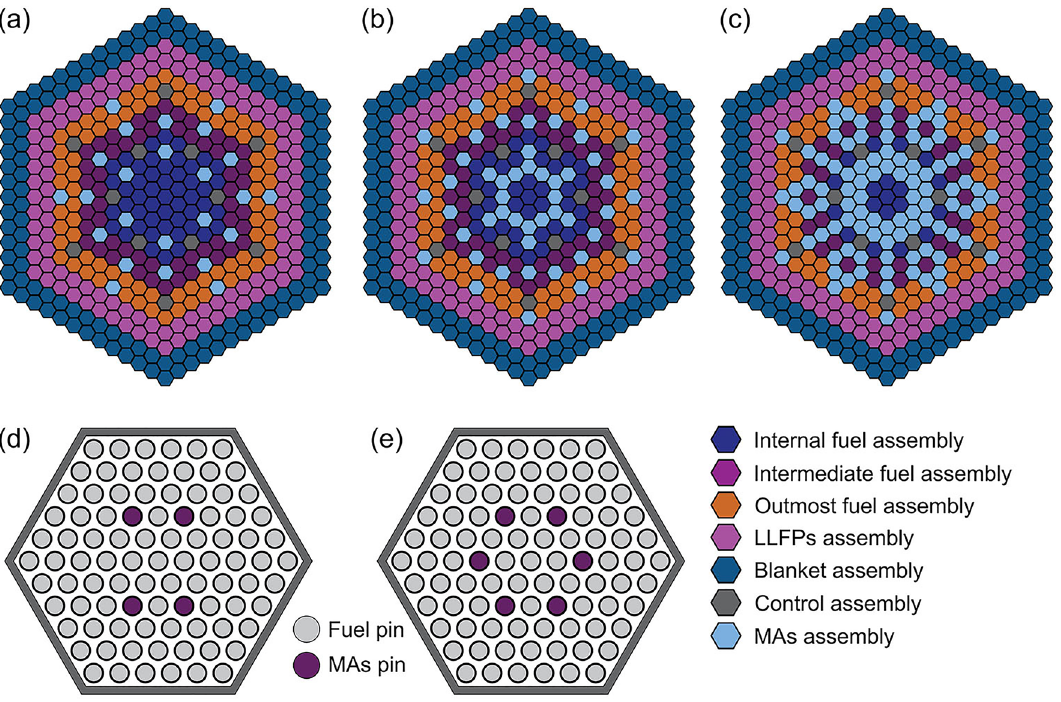
Figure 2. The distribution of MAs assembly in LFR with different loading amounts. In pads ( a ) and ( b ), the loading amounts are 0.5 wt% and 1.0 wt%, respectively and each MAs assembly contains four MAs pins, as shown in pad ( d ). In pads ( b ) and ( c ), the loading amounts are enhanced to 1.5 wt% and 2.0 wt%, respectively, and each MAs assembly contains six MAs pins, as shown in pad ( e ).